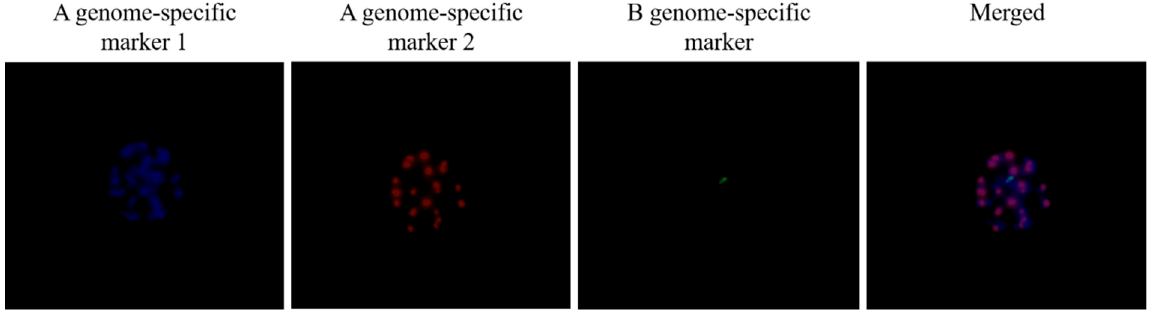
Figure 3. 18M-245 contains a monosomic chromosome derived from the Brassica B genome. FISH was performed using yellow flower buds from 18M-245. Brassica -A-genome-specific chromosomes were marked using A-genome-specific markers revealing blue and red fluorescence, while only one monosomic chromosome was marked with the B-genome-specific marker revealing green fluorescence, suggesting that the addition line was derived from the B genome.